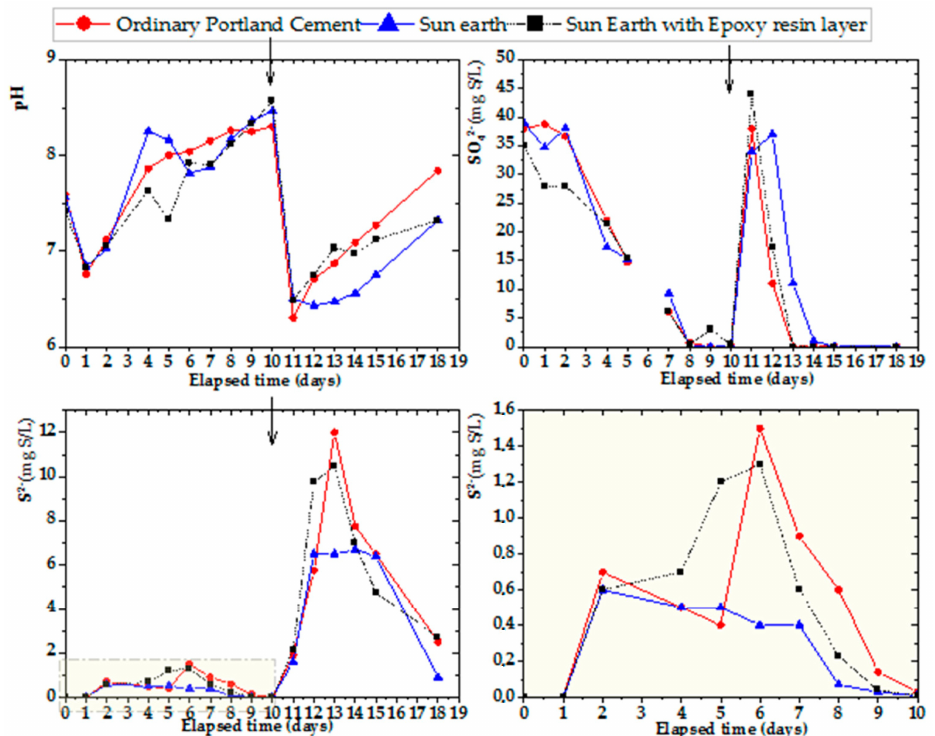
Figure 9. Experimental results for hydrogen sulfide inhibition effect of San-Earth/San-Earth with epoxy by time. Arrow ( ↓ ) indicates the addition of glucose (100 mg/L) and magnesium sulfate (33 mg